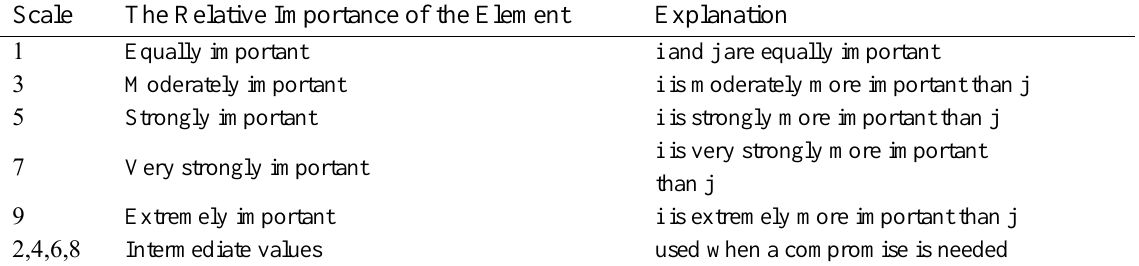
Table 1. The Saaty Rating